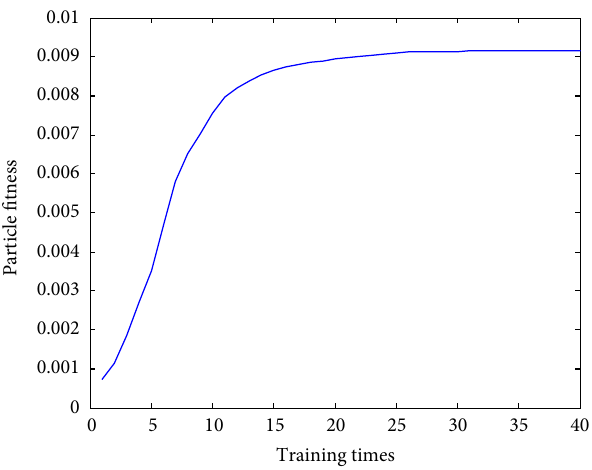
Figure 5: The optimization process of PSO